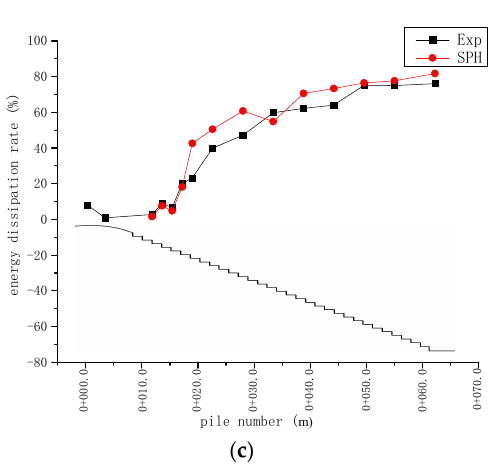
Figure 12. E nergy dissipation curves along the downstream direction of spillway for Figure 12. Energy dissipation curves along the downstream direction of spillway for different step different step numbers: ( a ) 62-step; ( b ) 45-step; ( c ) 31-step. numbers: ( a ) 62-step; ( b ) 45-step; ( c )